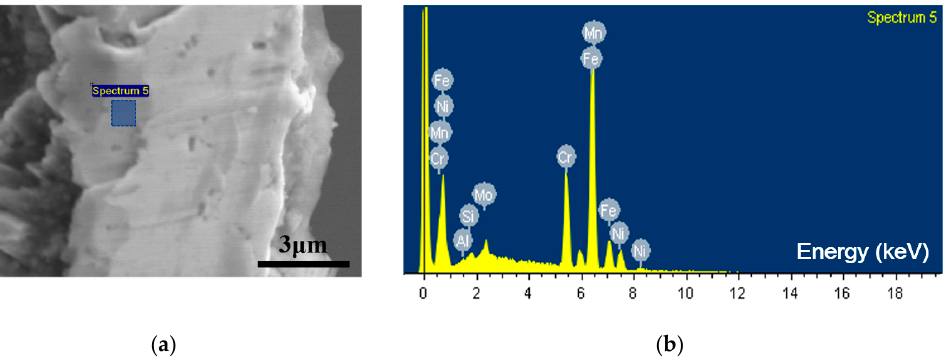
Figure 17. Shape and compositions of the fracture surface of FGM tensile specimen: ( a ) EDS analysis of shade area in fracture surface, shaded area; ( b ) EDS energy spectrum. Table 3. Compositions of the fracture surface of the FGM tensile test specimen and deposited pow- ders (wt%).